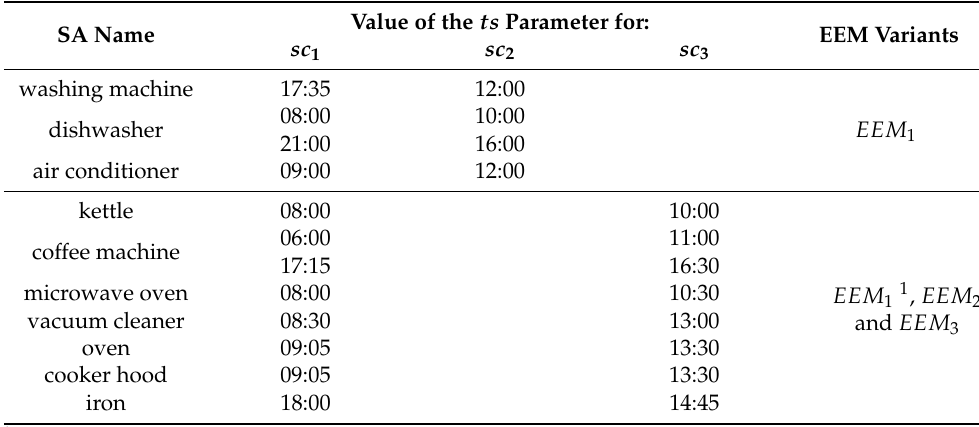
Figure 6. Compared power consumption ( ∑ P SA ) for three scenarios: without EEM ( sc 1 ), with EEM ( sc 2 ), and with EEM along with user behavior modification ( sc 3 ). Table 2. List of activation modifications for selected SAs by the EEM